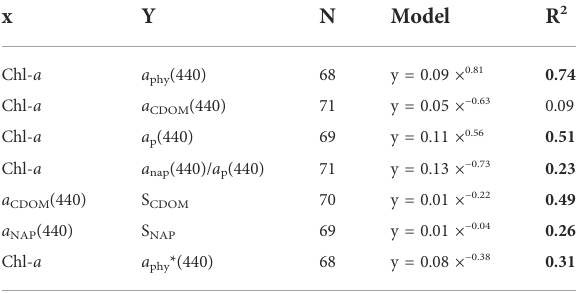
TABLE 4 Summary of selected optical properties relationships in the Abrolhos Bank region with their respective statistical performance.